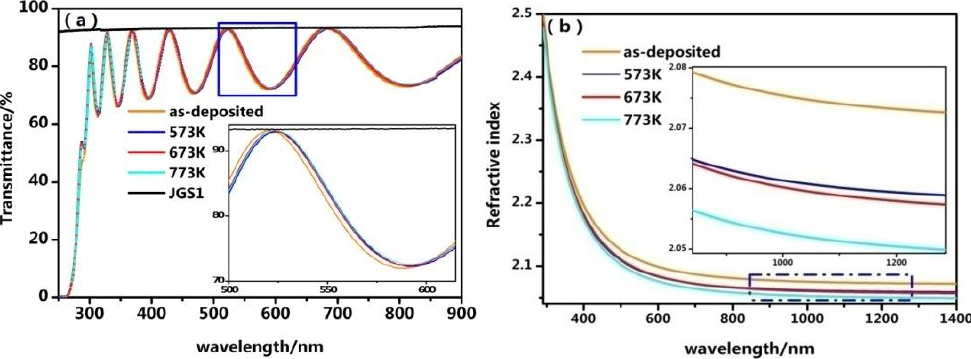
Figure 5. Optical properties of Ta 2 O 5 films with a thickness of 500 nm annealed at various temperatures in the range from 573 to 773 K. ( a ) Transmittance spectra of annealed samples, the wavelength ranging from 250 to 900 nm; and ( b ) the refractive index of annealed samples, the wavelength ranging from 300 to 1400 nm.